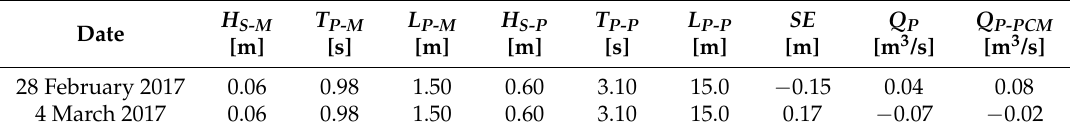
Table 6. Field measured discharge values through the flushing culvert and predicted discharge values according to the proposed Equation (1), in regards to the present wave